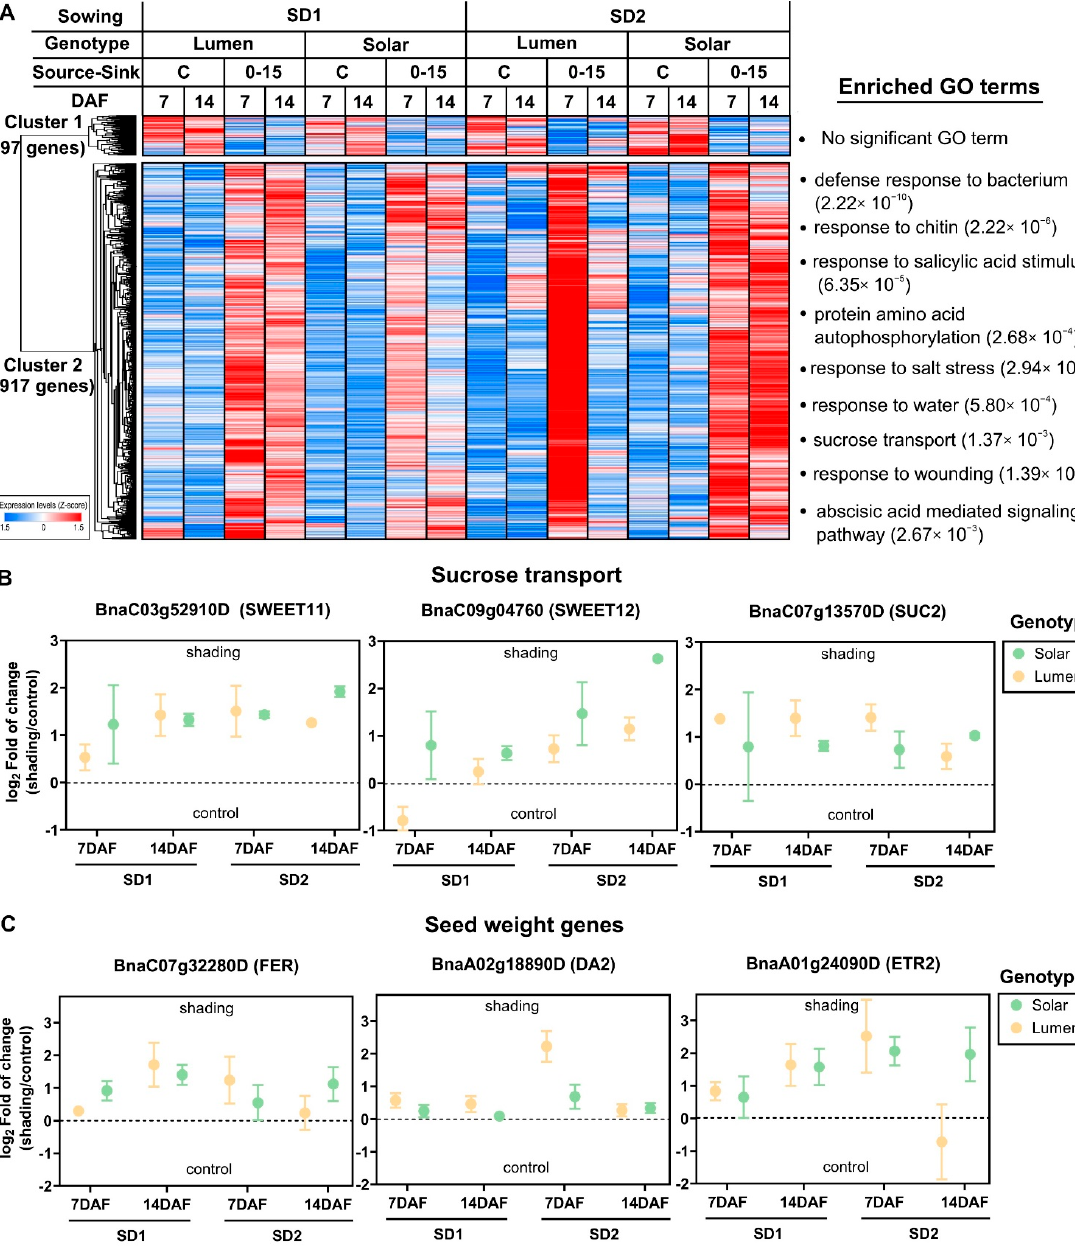
Figure 3. Reduction in the source–sink ratio during seed filling induces the expression of genes involved in sucrose transport, seed weight, and stress response. ( A ) A heatmap showing the two major expression patterns of genes exclusively regulated by shading treatment. Hierarchical clustering was performed based on Pearson correlation distances and average linkage using Morpheus software [29]. Each column of the heatmap represents the average expression of three biological replicates. The gene expression values for each gene were normalized by Z-score transformation. The significant and nonredundant GO terms (adjusted p -value < 0.05) of the biological process domain are represented on the right side of each cluster. GO term enrichment analysis was performed by a hypergeometric test using BiNGO software [28]. FDR-adjusted p -values are indicated for each GO term in brackets. ( B ) Expression profiles of three representative genes belongs to the GO term “sucrose transport”. The dots represent the average log 2 fold change between the shading and control samples obtained from normalized RNA-seq data, whereas bars indicate the standard error of the mean (SEM) of three replicates. The Arabidopsis ortholog of each rapeseed gene is indicated in brackets. ( C ) Expression profiles of three representative genes for which the orthologs in Arabidopsis are involved in seed weight regulation. The dots represent the average log 2 fold of change between shading and control samples obtained from normalized RNA-seq data, whereas bars indicate the standard error of the mean (SEM) of three replicates. The Arabidopsis ortholog of each rapeseed gene is indicated in